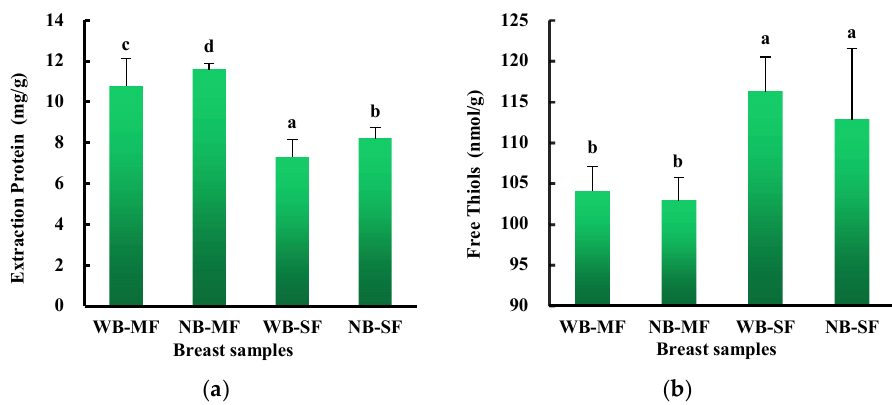
Figure 5. Protein extraction content ( a ) and free thiol content ( b ) in wooden breast (WB) and normal breast (NB) muscles of broilers in myofibrillar (MF) and sarcoplasmic (SF) protein fractions. Means within groups without a match in superscripts (abcd) differ, p < 0.05.